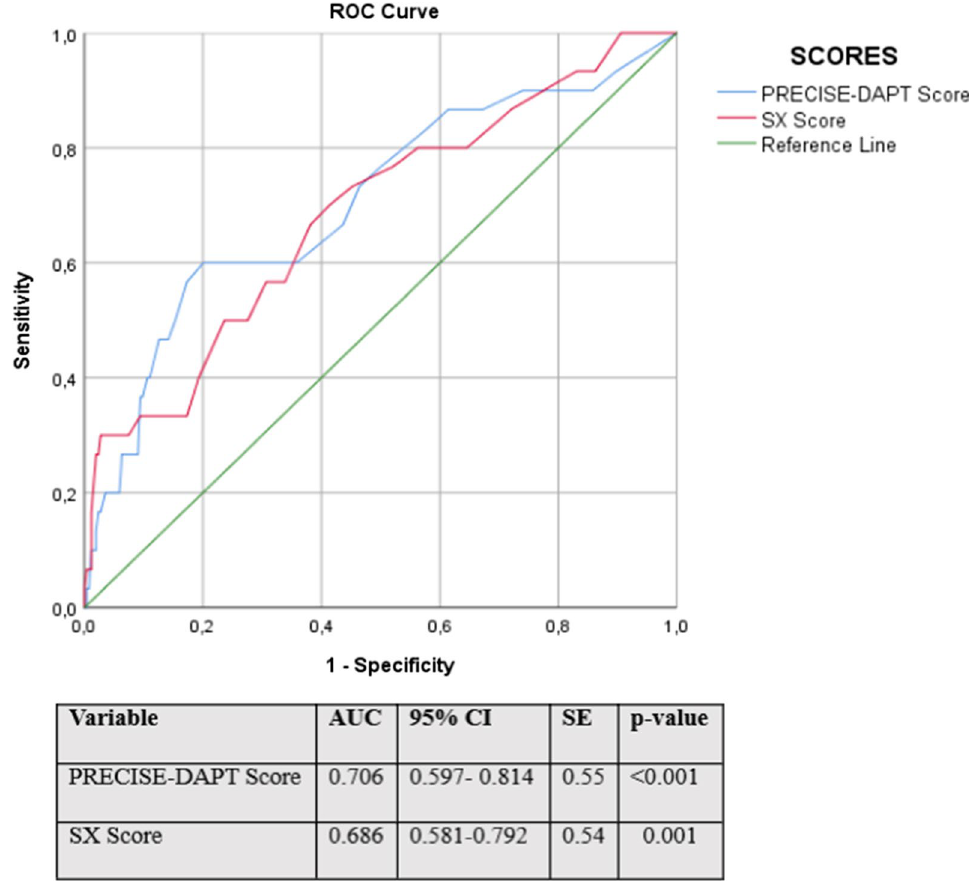
Fig. 2 Receiver operating characteristic curve analysis of PRECISE-DAPT and SX scores for predicting in-hospital